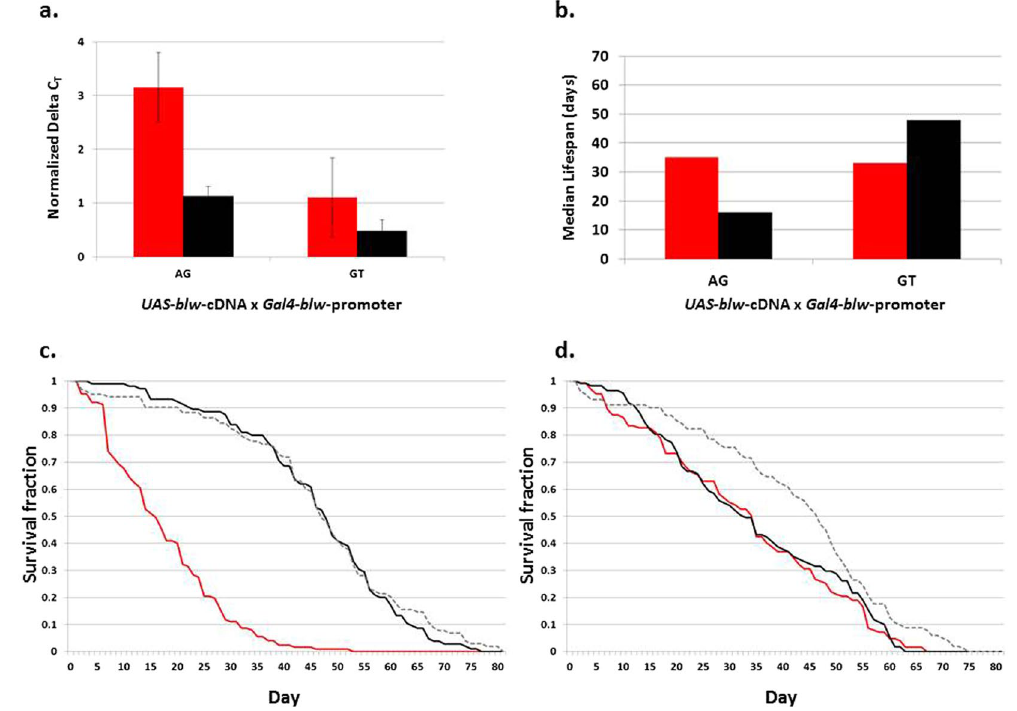
Figure 3. Effect of blw -cDNA overexpression on lifespan. ( a ) Normalized expression levels measured by quantitative RT-PCR of blw -cDNA when driven by the blw -AG and blw -GT promoters (red, females; black, males). ( b ) Median lifespan of flies that overexpress blw -cDNA from the blw -AG and blw -GT promoters (red, females; black, males). ( c ) Survival curves of male flies overexpressing blw -cDNA when driven by either the blw -AG (red) or blw -GT promoter (black). ( d ) Survival curves of female flies overexpressing blw -cDNA when driven by either the blw -AG (red) or blw -GT promoter (black). The control flies expressing the endogenous blw gene are shown by gray dotted